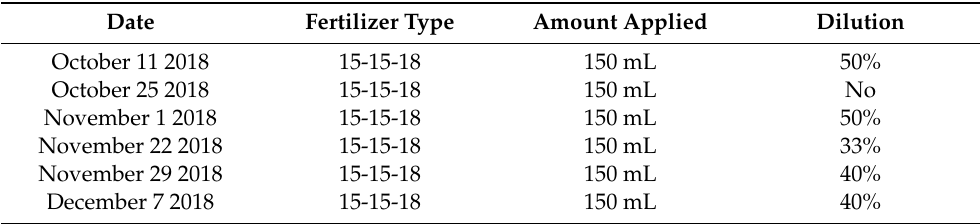
Table A2. Fertilizer application for Vitis vinifera cuttings in native and cultivar studies. Miracle-Gro fertilizer was used to prepare solutions of varying concentrations. Enough fertilizer was applied to cover the soil and soak through.